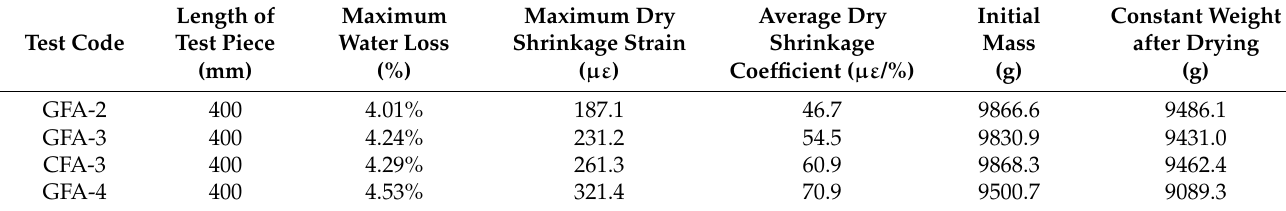
Table 6. Results of dry